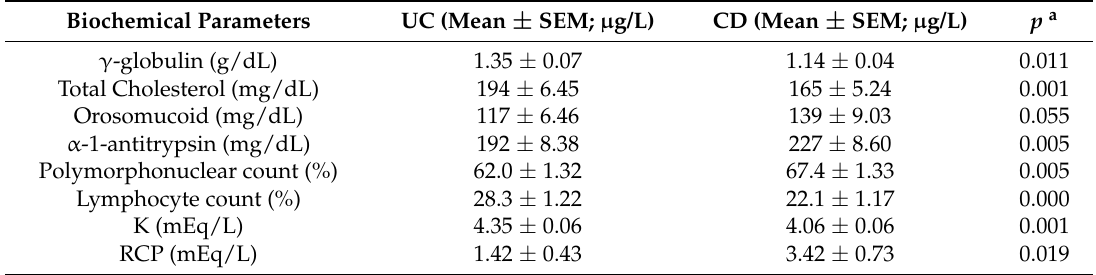
Table 3. Biochemical values showing significant difference ( p < 0.05) between UC and CD patients.